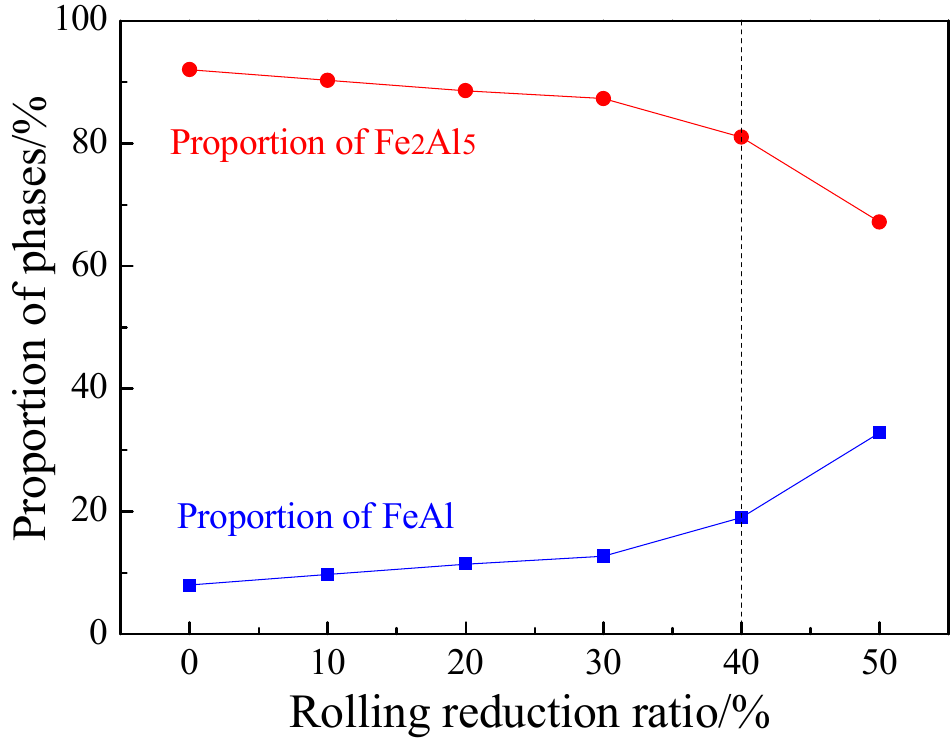
Figure 11. Proportion of Al-Fe layer phases at different reduction ratios at TAUS = 930 ◦ C for 5 min. The structures and thickness of the austenitized coatings at different cold rolling reduction ratios were shown in Figures 12 and 13. The structural morphology of